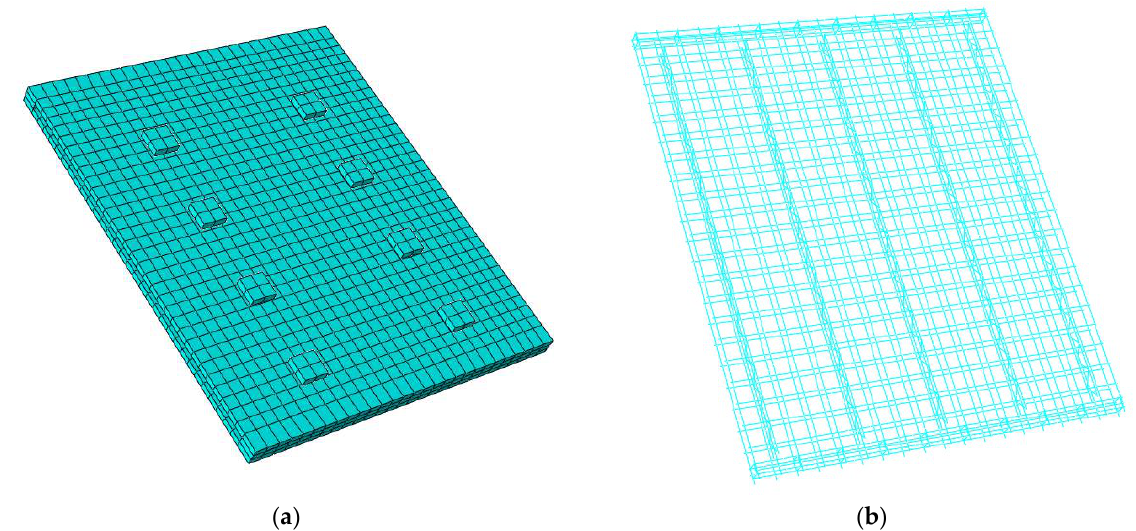
Figure 12. Finite element model of sandwich wall with reasonable mesh sizes. ( a ) Concrete layer. ( b ) Reinforcements.